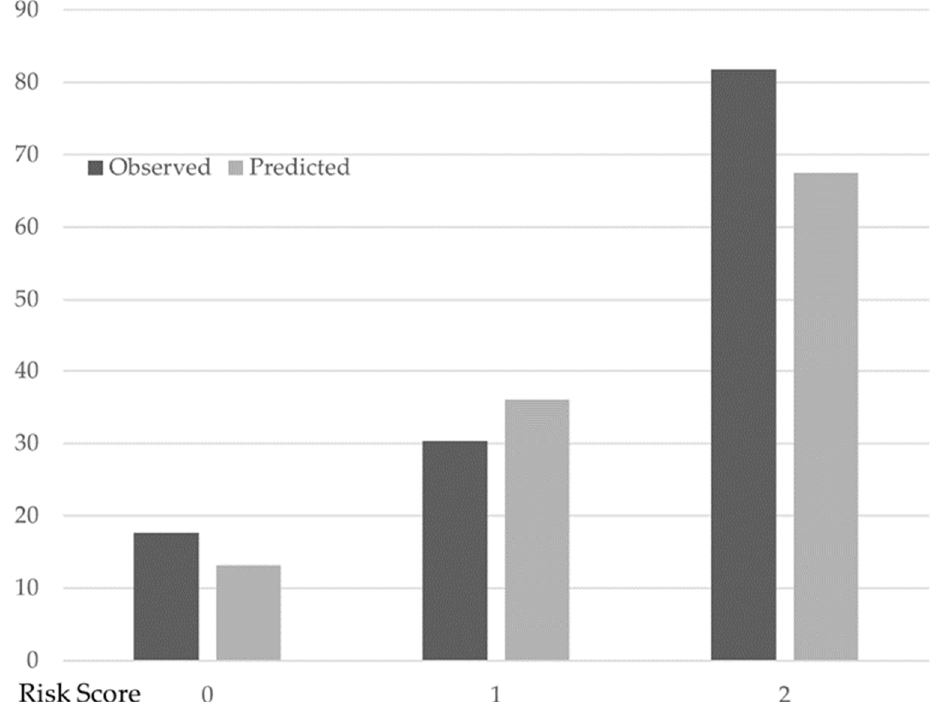
Figure 2. Observed and predicted the probability of PCS change with different factors associated with the change in PCS scores. Filled bars indicate the observed probability of the change in PCS. Open bars indicate the predicted probability of the change in PCS based on multivariable logistic regression analysis. Change in PCS: 7 (factor score: 0), 17 (factor score: 1), 2 (factor score: 2). No change in PCS: 34 (factor score: 0), 39 (factor score: 1), 9 (factor score: